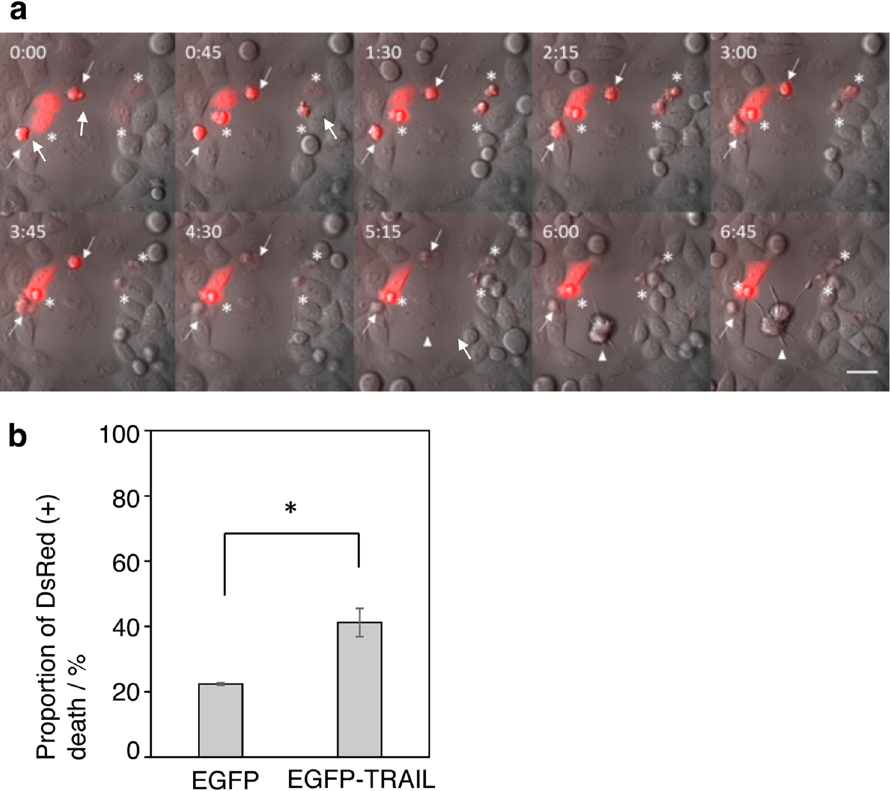
Figure 4. Light-induced elimination of cancer cells by DOTAP-AuNRs. HeLa cells were cotransfected with pCMV-DsRed and either pHSP70-EGFP or pHSP70-EGFP-TRAIL by DOTAP-AuNRs and photoinduced. ( a ) Montage shows time lapse of 45-minute interval of pHSP70-EGFP-TRAIL transfected cells (Supplementary Movie S1). Time 0:00 refers to start of time lapse. Time lapse started approximately 3 hours after laser irradiation. Arrows show DsRed positive cells that had died before start of time lapse imaging. Asterisks show DsRed positive cells that die during time lapse imaging. Arrowhead shows DsRed negative cell that dies during time lapse imaging. Scale bar = 40 µ m. ( b ) Total number of DsRed positive cells and DsRed positive cell deaths were counted in time lapse imaging taken 3–20 hours post-photoinduction. GFP (n = 2), GFP-TRAIL (n = 3), 15–20 cells per experiment. * Indicates P < 0.05 with Student’s